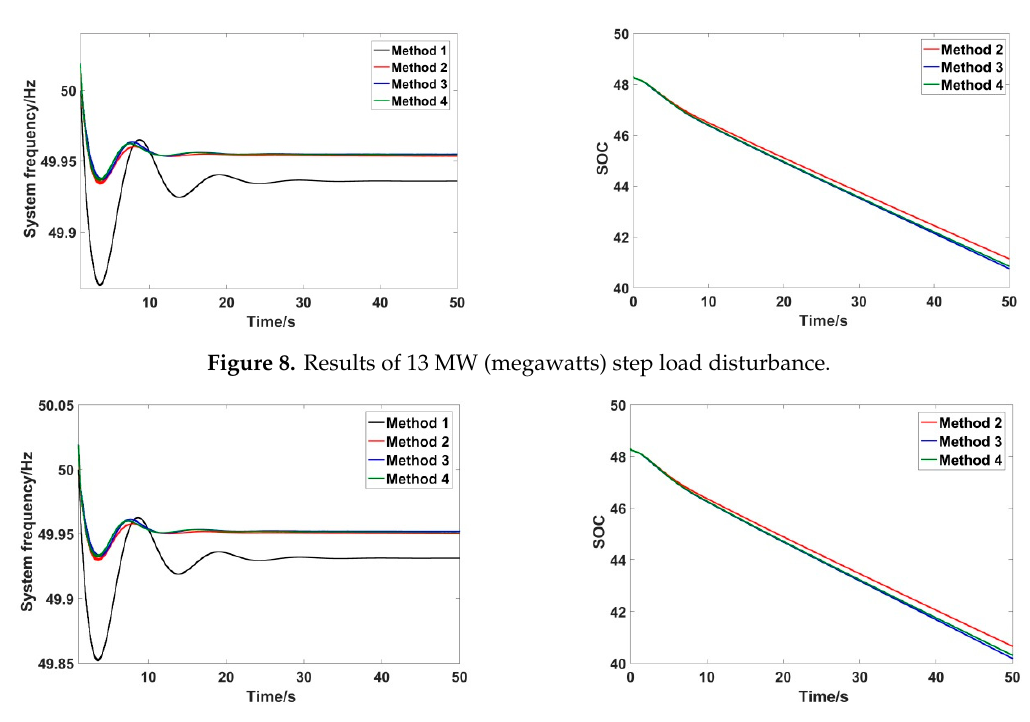
Figure 9. Results of 14 MW step load disturbance.